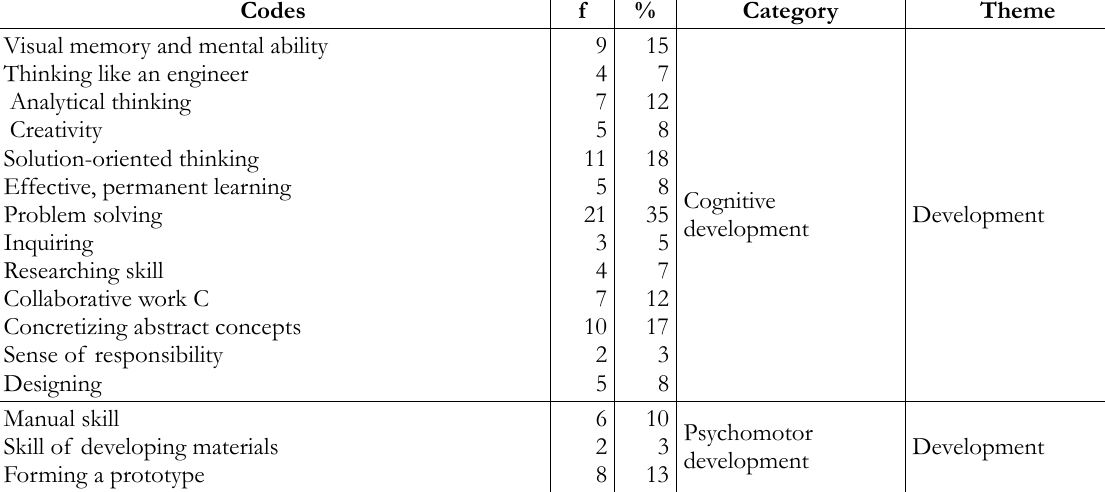
Table 4. Results belonging to the analysis of the third question related to the characteristics and the skills developed by doing a lesson in accordance with the STEM plan in